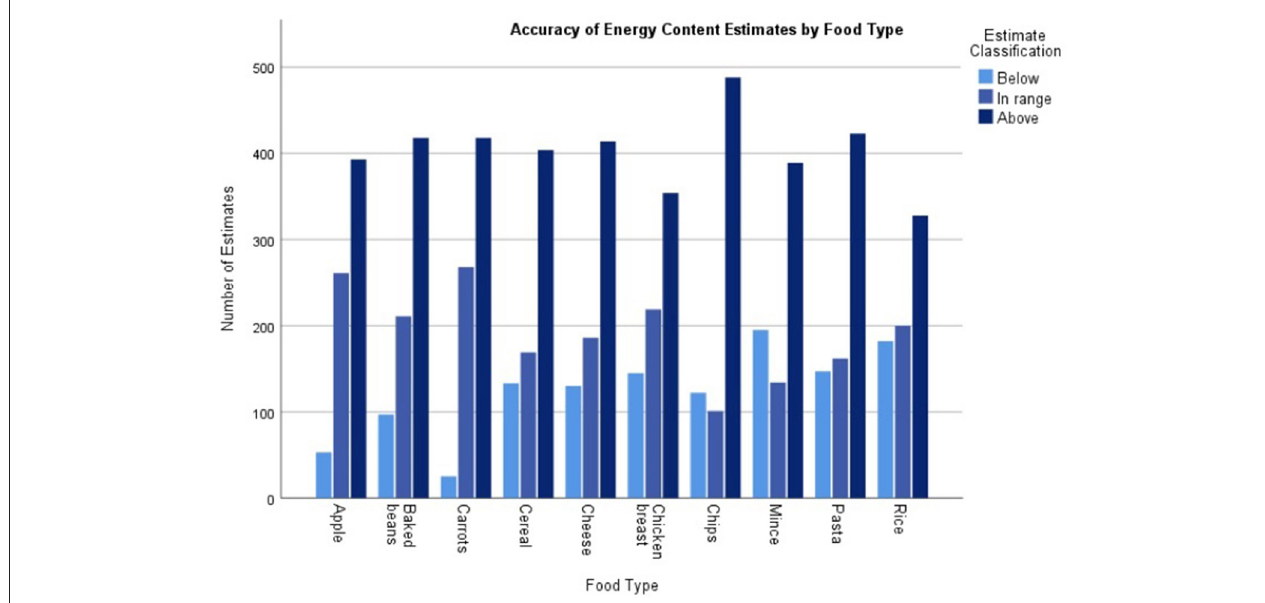
FIGURE 3 | Accuracy of energy content estimates for each food type.